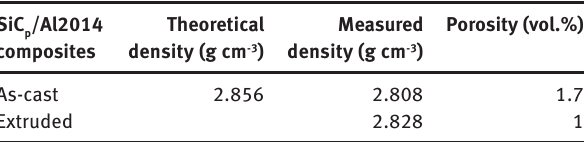
Table 1: Density and porosity of the 4 vol.% SiC sites before and after